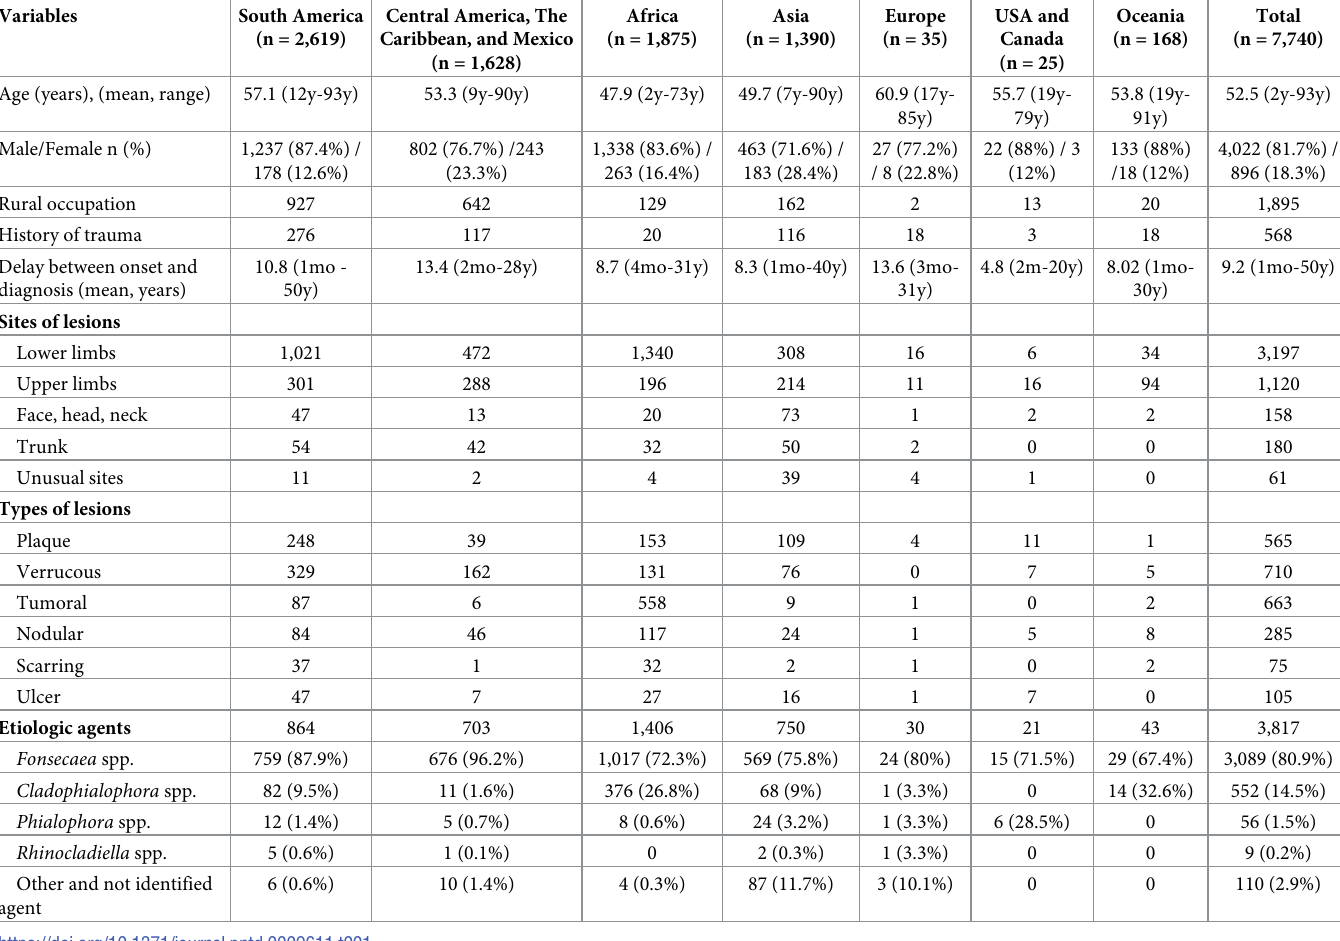
Table 1. Epidemiology and main clinical aspects of 7,740 cases of chromoblastomycosis documented in 5 different continents.